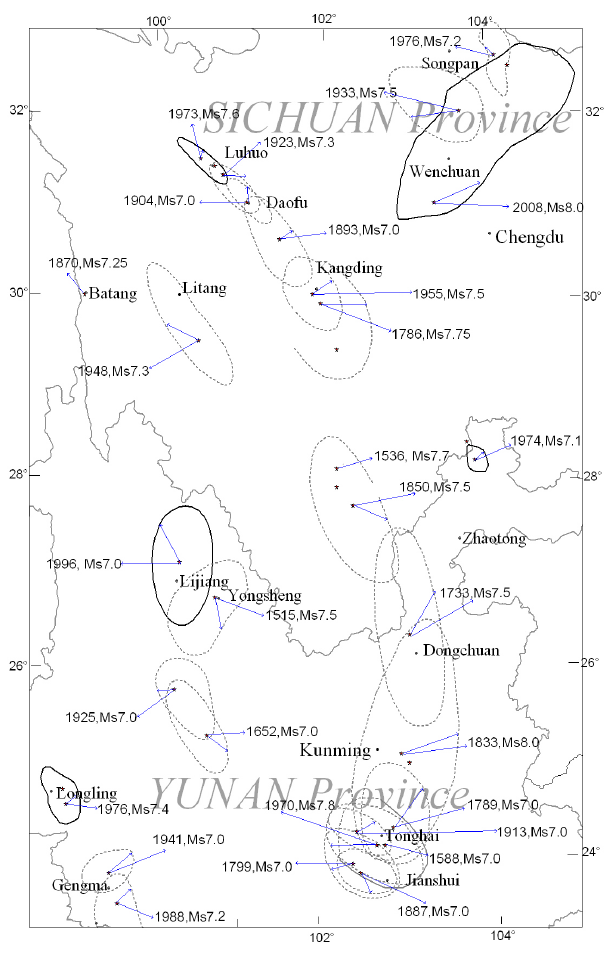
Fig. 7. Earthquake epicentres and area of associated landslides in southwest China (solid lines are the earthquakes having detailed landslides records, dash lines are inferred from the history docu- ments, which using seismic intensity line of VII for instead).